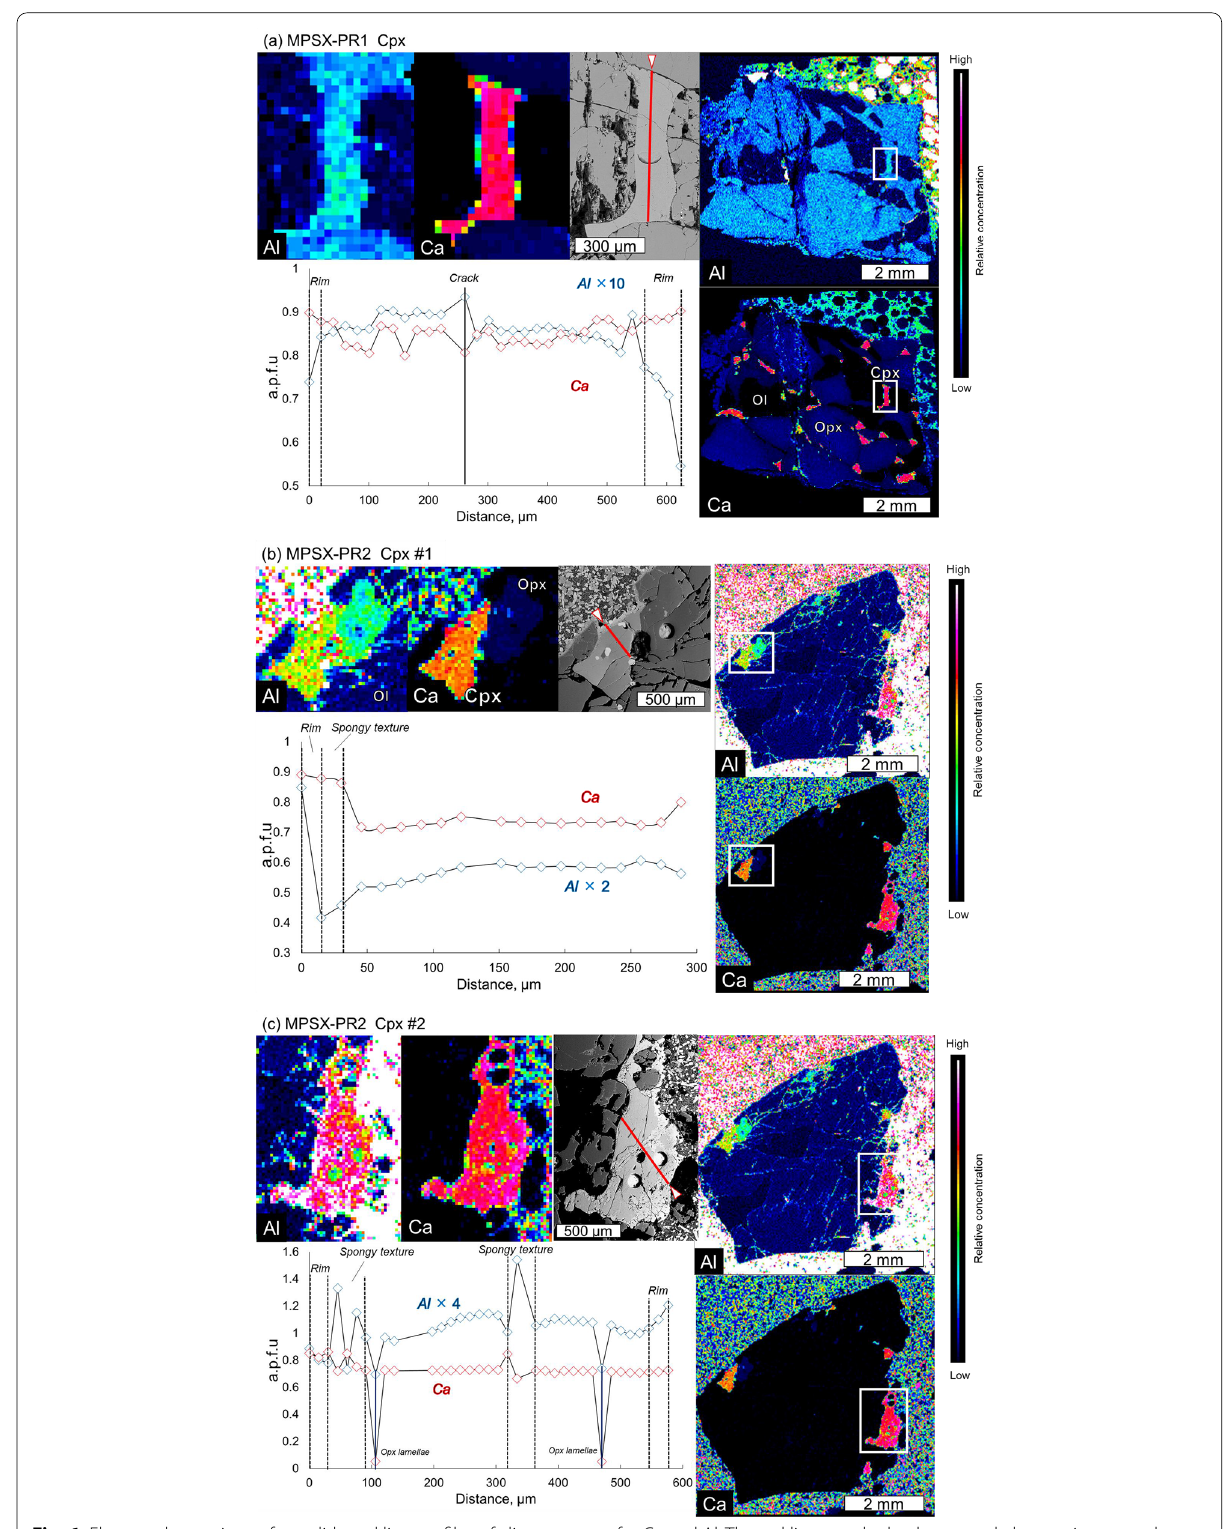
Fig. 6 Elemental mappings of xenolith and line profiles of clinopyroxene for Ca and Al. The red lines on the backscattered electron image and white lines on the elemental map are the analyzed lines. Triangle symbols indicate the starting points. In the a.p.f.u (atoms per formula unit) vs. distance diagram, the red and blue diamonds display Ca and Al cation numbers, respectively. The cation numbers for Al are multiplied by a constant for ease of viewing. a MPSX-PR1. b , c MPSX-PR2. d MPSX-PX1. e MPSX-PX2. f MPSX-PX3. g MPSX-PX4. h MPSX-PX5. i